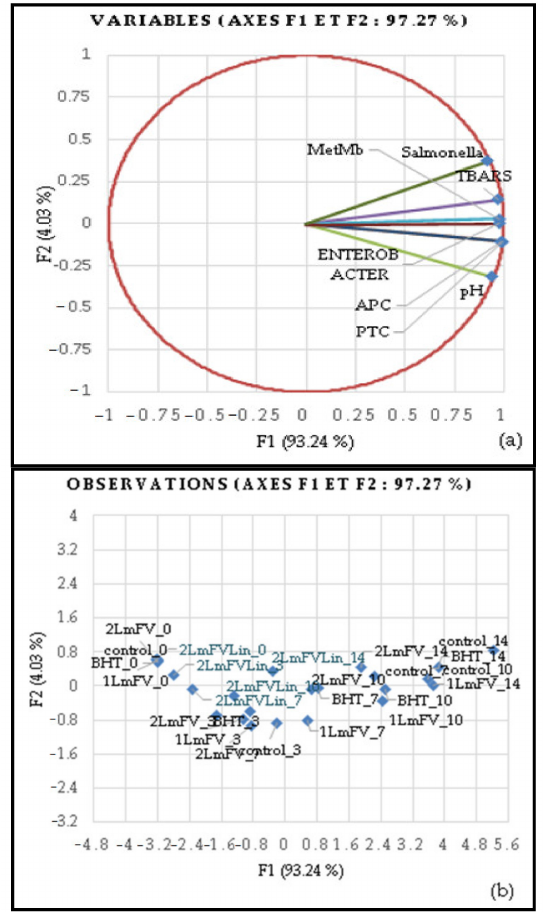
Figure 6. Loading plots of the two principal components (F1, F2) based on all samples (n = 25) ( a ) and on physicochemical and microbial growth of meat samples over 14 days of storage ( b